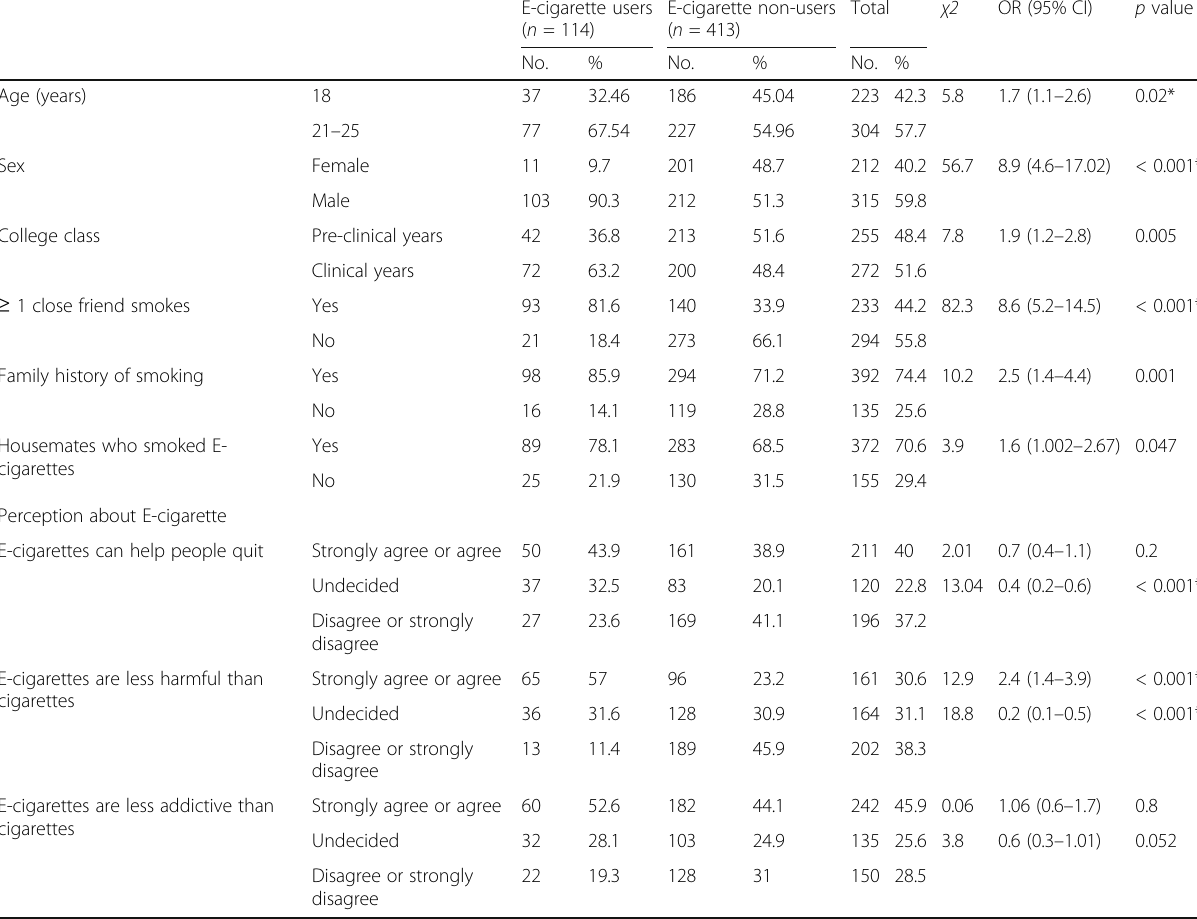
Table 1 Comparison between E-cigarette users and non-users regarding demographic characteristics and perception of E-cigarette, Medical College, Taibah University, KSA ( n =